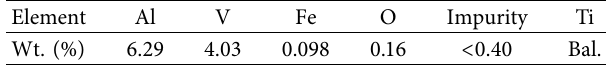
Table 1: Main chemical composition of Ti-6Al-4V alloy.